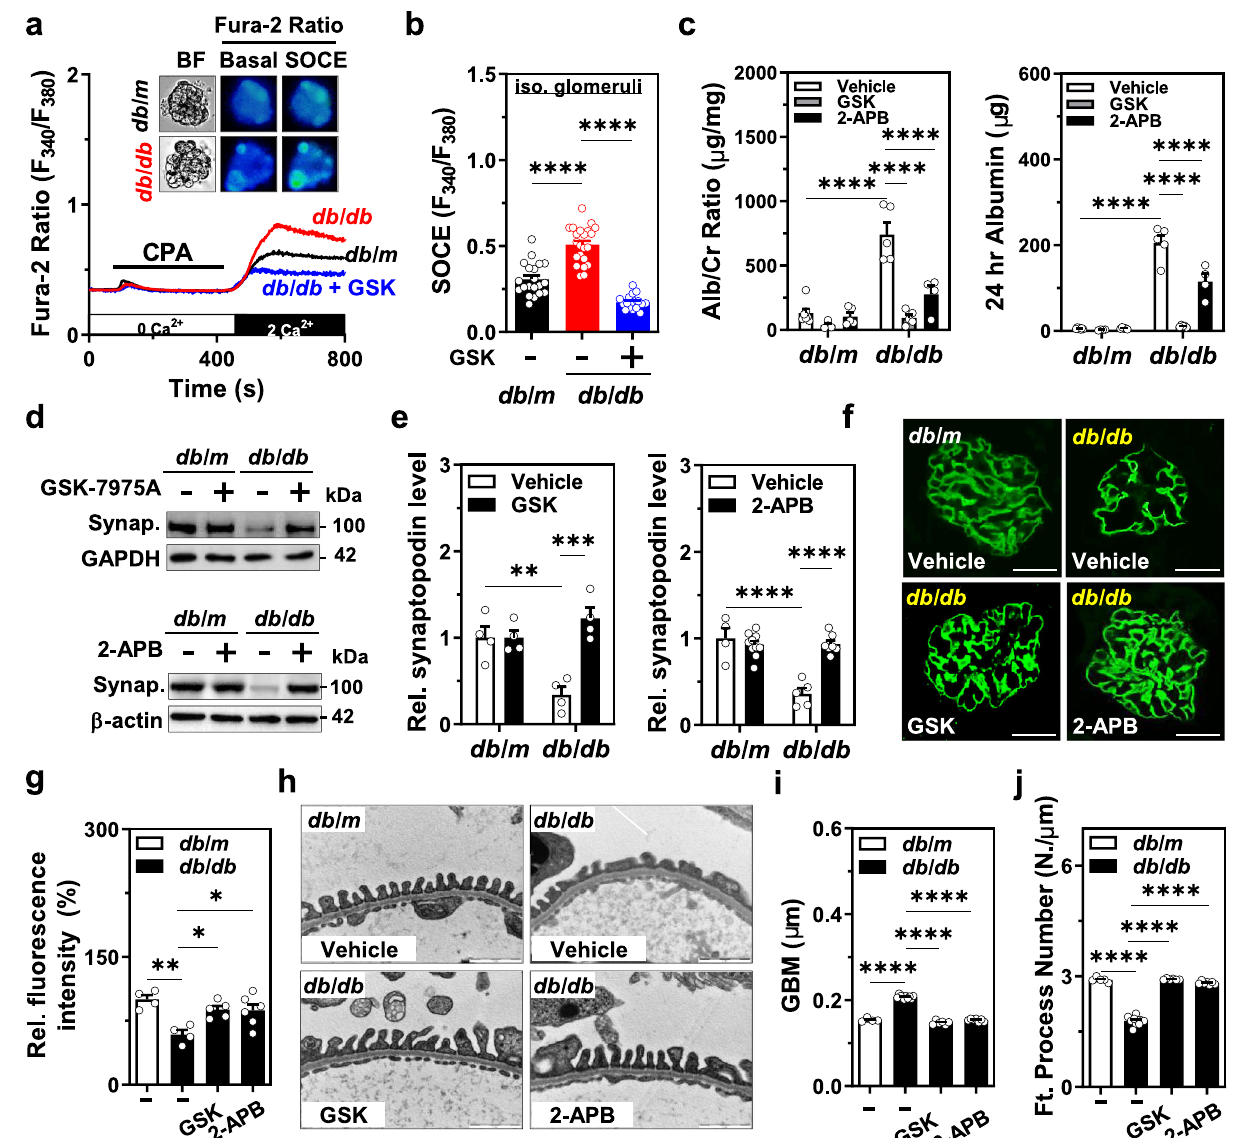
Fig. 6 Orai1 inhibition protects podocyte foot processes and proteinuria. a Representative traces of fura-2 ratio and the images of bright- fi eld and fura-2 fl uorescence microscopy (upper panel) of podocytes, carried out in situ on the acutely isolated mouse in db/m and db/db mice treated with GSK-7975A (5 mg/kg/day for 1 month). b Summary of the SOCE in a . n = 20 ( db/m + Vehicle), 22( db/db + Vehicle), and 17 ( db/db + GSK) glomeruli per each group, respectively. c Effect of SOCE inhibitors on albuminuria. Twenty-four-hour urinary Alb/Cr ratio (left) and albumin excretion (right) were measured in db/m and db/db mice. Vehicle (PBS), GSK-7975A (GSK, 5 mg/kg/every 2 days) or 2-APB (2 mg/kg/every 2 days) were inoculated i.p . from 8 to 12 weeks. n = 7 ( db/m + Veh), 4 ( db/m + GSK), 5 ( db/m + 2-APB), 5 ( db/db + Veh), 5 ( db/db + GSK), and 4 ( db/db + 2-APB). d Representative immunoblots representing the effects of SOCE inhibitors, GSK-7975A (upper) or 2-APB (lower), on synaptopodin expression from db/m and db/db mice. e Summary of quanti fi cation in d . n = 4 mice each (left). n = 4 ( db/m + Veh), 10 ( db/m + 2-APB), 5 ( db/db + Veh), and 7 ( db/db + 2-APB) (right). f Rescue of synaptopodin depletion by SOCE inhibitors (GSK or 2-APB). Synaptopodin staining (green) of mouse glomeruli from db/m and db/db mice with or without GSK or 2-APB i.p . injection. Scale bar = 25 μ m. g Analysis of the relative fl uorescence intensity in f . n = 4 ( db/db + Veh), 4 ( db/db + Veh), 5 ( db/db + GSK), and 6 ( db/db + 2-APB). Thirty images from mice in each group. h Representative TEM images of the foot processes of the podocytes of SOCE inhibitor-treated db/db mice. Magni fi cation is ×30,000. Scale bar = 1 μ m. i , j Summary of GBM thickness ( i ) and an average number of foot processes per 1 μ m length of GBM ( j ) in h . n = 4 ( db/m + Veh), 10 ( db/db + Veh), 6 ( db/db + GSK), and 7 ( db/db + 2-APB) thirty images from mice in each group. Data are expressed as mean ± SEM and were analyzed using two-way ANOVA followed by Tukey ’ s multiple comparisons test. * p < 0.05, ** p < 0.01, **** p < 0.0001; ns not signi fi